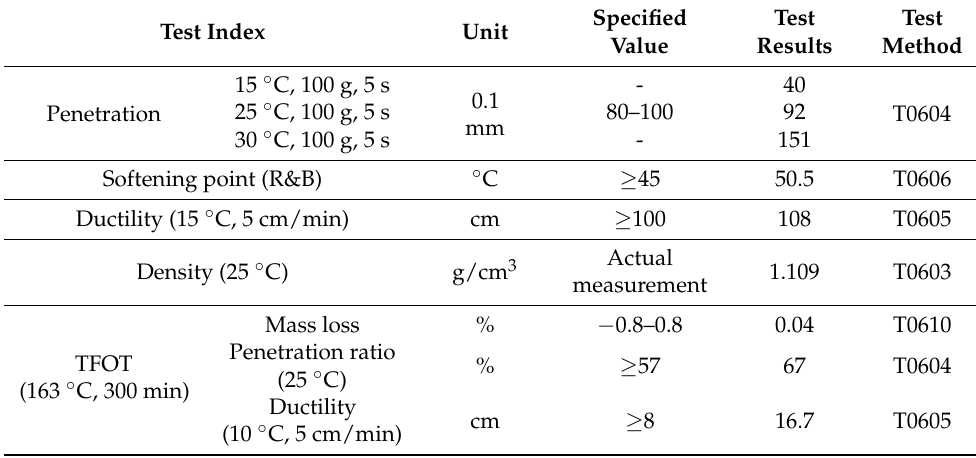
Table 2. Technical indexes of 90 # base